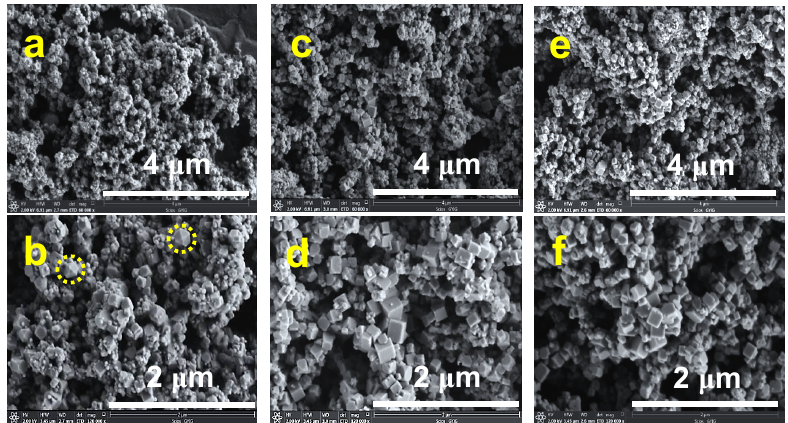
Figure 5. SEM images of the as-synthesized pyrite nanocrystals at 24 h with different concentrations of thiourea as the sulfur source: ( a,b ) 40 mmol/L, ( c,d ) 80 mmol/L, and ( e,f ) 160 mmol/L.